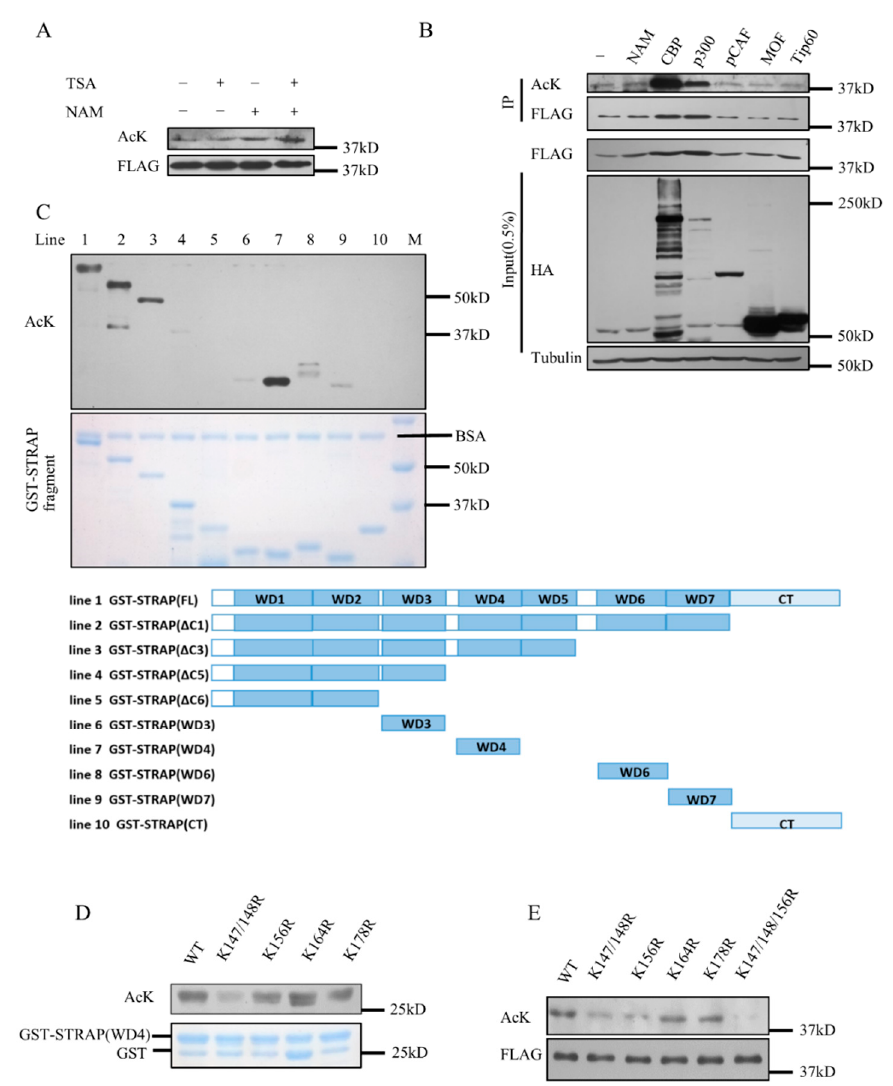
Figure 2. STRAP is acetylated at lysines 147, 148, and 156. ( A ) HEK293T cells were transfected with Flag-STRAP for 24 h and incubated with or without 1 µ M TSA and / or 5 mM nicotinamide (NAM), as indicated, for an additional 6 h. An in vivo acetylation assay and Western-blotting analysis were performed. ( B ) HEK293T cells were co-transfected with plasmids containing Flag-STRAP and di ff erent HA (Hemagglutinin)-tagged acetyltransferases, CBP, p300, PCAF, hMOF, or Tip60. Whole-cell lysates were immune-precipitated with M2 beads and analyzed by Western blotting with indicated antibodies. ( C ) Ten types of GST-STRAP fusion proteins were used for in vitro acetylation assays. Western-blotting data (upper panel). Gel code blue staining (bottom panel). ( D ) GST-STRAP (WD4) Wild-type or the K to R mutant GST-STRAP (WD4) fusion proteins were used for in vitro acetylation assays. ( E ) HEK293T cells were transfected with wild-type or the indicated K to R mutant Flag-tagged STRAP constructs for 24 h and incubated with 1 µ M TSA and 5 mM NAM for an additional 6 h. The levels of acetylation and total STRAP protein were detected after anti-Flag M2